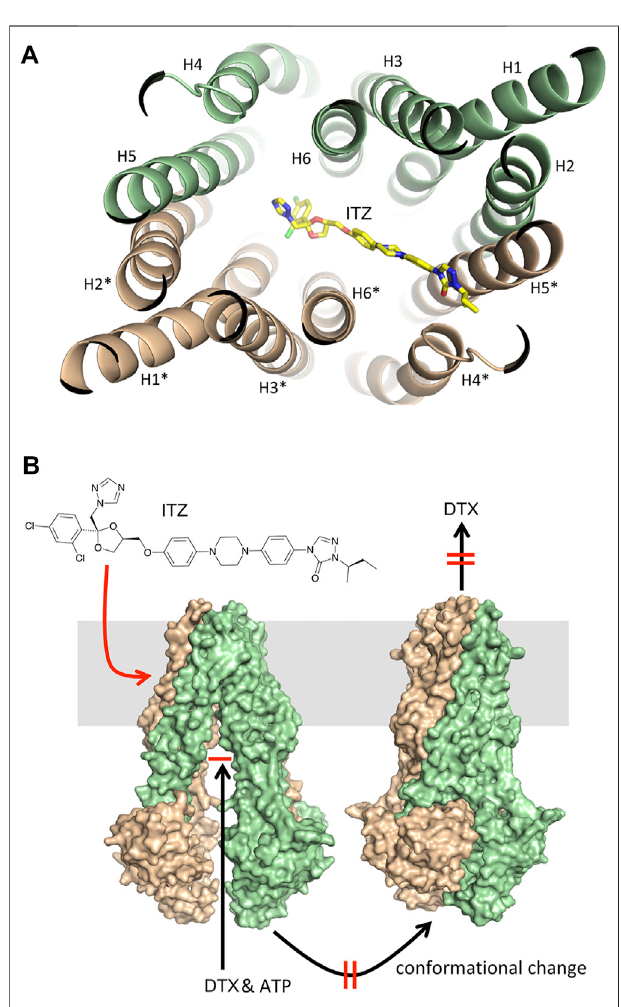
FIGURE 5 | Molecular docking. (A) Illustration of the preferred binding mode of itraconazole between the trans-membrane helices in the inward- facing form of P-gp CmABCB1. The helices are shown as light green and beige cartoons numbered analogously with the numbering reported by Kodan and colleagues (Kodan et al., 2019). Itraconazole is displayed as a color-typed stick model. (B) Illustration of the P-gp mediated transport of docetaxel involving docetaxel binding to the inward-facing form, the ATP induced conformational change to the outward-facing form and subsequent release ofdocetaxel (black arrows) and the effect ofitraconazoleby binding to the inward-facing form, and thereby inhibiting the conformational change and thus the transport of docetaxel across the membrane (red arrow and